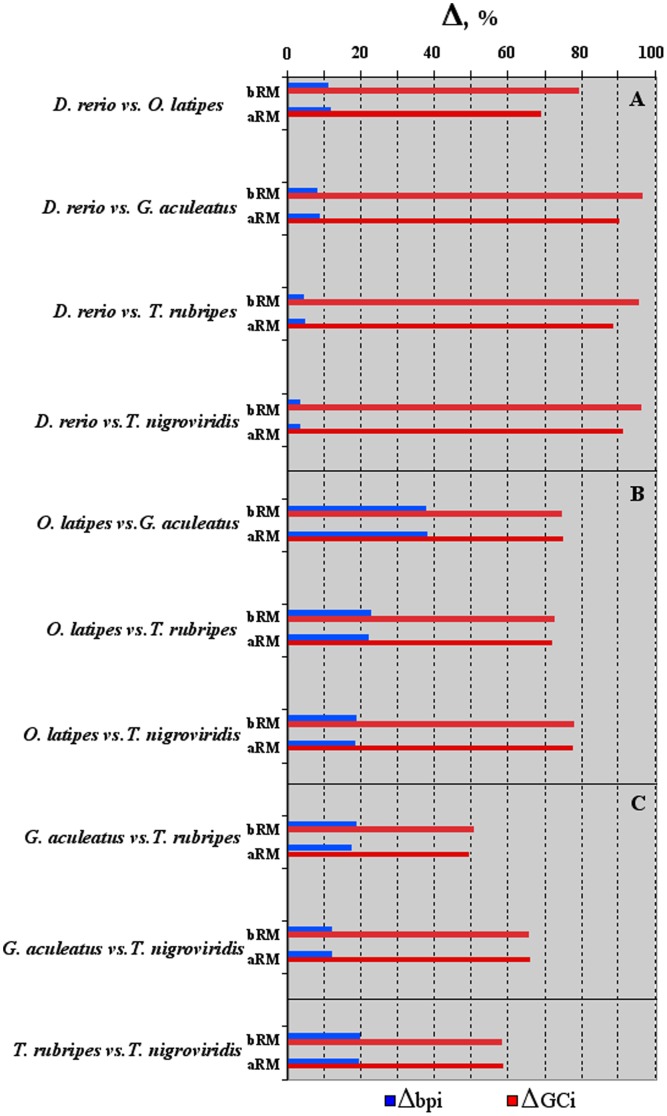
The histogram shows the percents of orthologous intronic sequences increasing in length (Δbpi, blue bars) and GC content (ΔGCi, red bars) in each pairwise comparison.Data before (bRM) and after (aRM) RepeatMasker are reported. In cluster A: comparison of medaka, stickleback, fugu and pufferfish against zebrafish. In cluster B: comparison of stickleback, fugu and pufferfish against medaka. In cluster C: comparison of fugu and pufferfish against stickleback. Within each cluster pairwise comparisons were ordered according to the increasing phylogenetic distance.